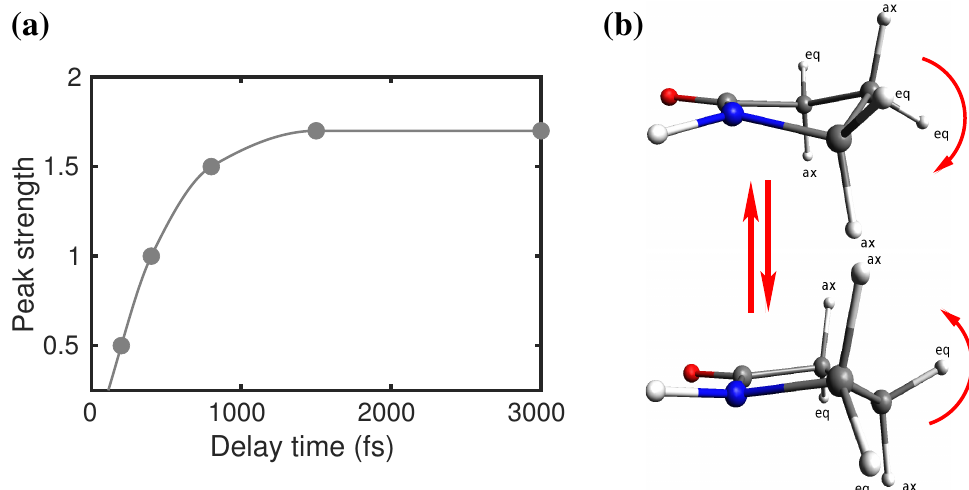
Figure 13. Waiting time (T w ) vs. peak intensity for the cross-peak at position (2880, 1710cm − 1 ). The peak intensity grows very fast at an early waiting time and practically reaches saturation at a waiting time of